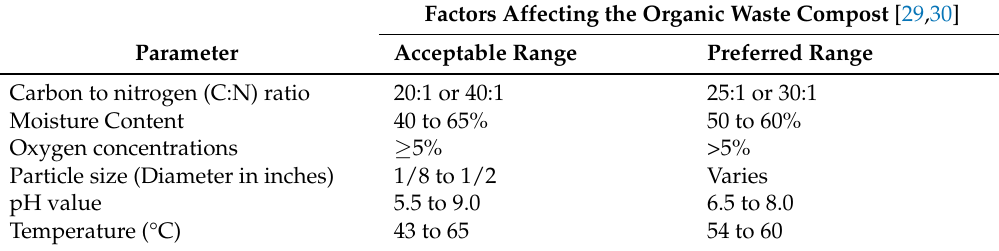
Table 2. Key parameters for organic composting and the recommended